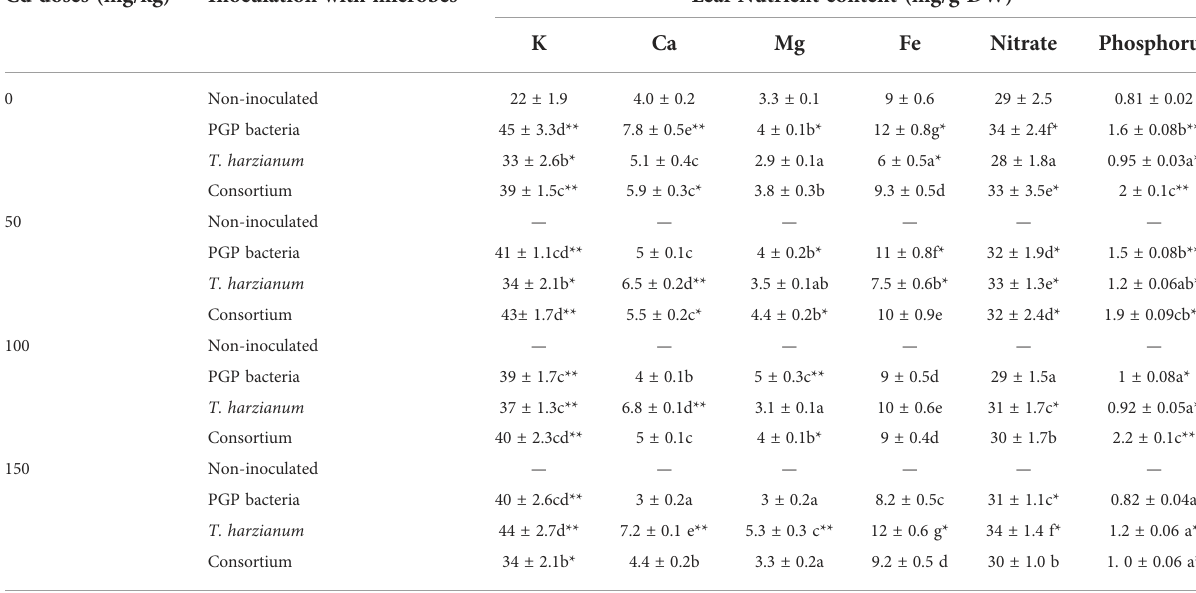
TABLE 5 Average values of Leaf Nutrient content (K, Mg, Ca, Fe, nitrate, and phosphorus) of sun fl ower inoculated and non-inoculated with PGP bacteria, T. harzianum , and Consortium and affected by different levels of Cd (0, 50, 100, and 150 mg/kg dry soil). Cd doses (mg/kg) Inoculation with